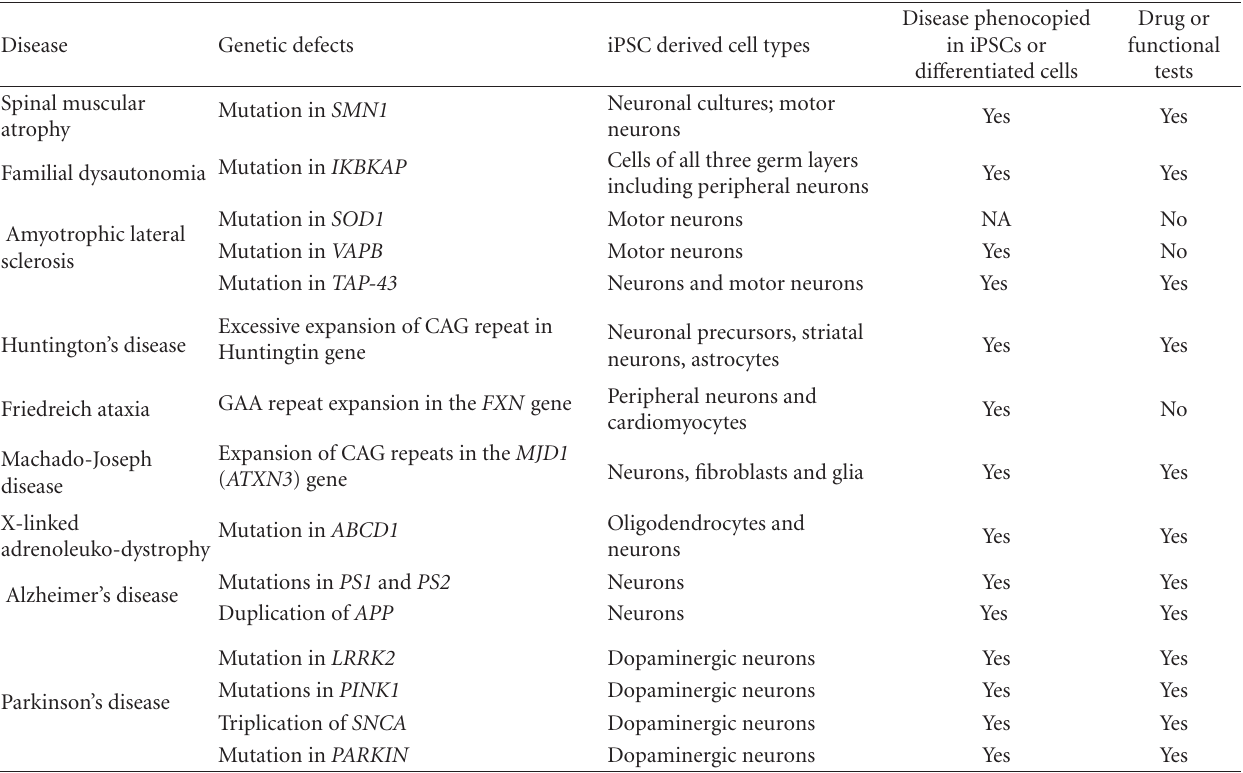
Table 2: Genetic neurodegenerative disorders modeled with